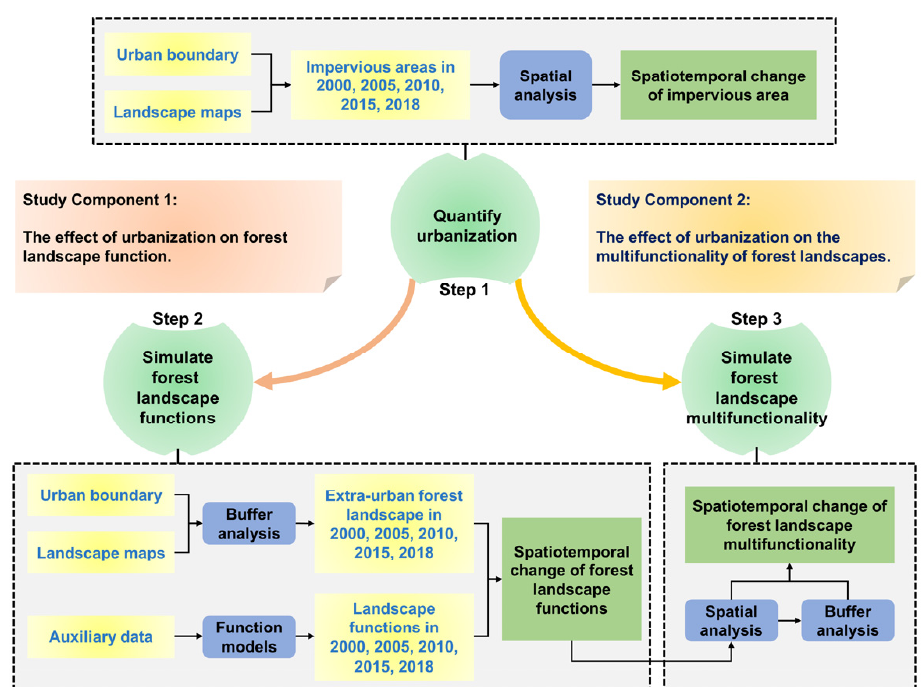
Figure 2. The flowchart shows the research framework and technical route of this study. The habitat maintenance (HM) function refers to the ability of local forest landscape systems to maintain biodiversity. The present study assessed changes in HM functions between 2000–2018 using the Habitat Quality module of the Integrated Valuation of Ecosys- tem Services and Trade-offs (InVEST) model [35]. In this module, the mandatory input data include three categories: landscape type maps, threat data for maintaining habitat, and landscape sensitivity to threats. Maps of landscape types are available in the CLCD data. Threat data and sensitive data are determined by referring to the user manual of InVEST and related studies [35,37–39]. By investigating the landscape composition of the study area, we determined that the threat factors included cropland, impervious areas, and bare land. Table A1 shows the threat data and sensitive data used in this study. Equation (3) shows the basic formula for assessing HM function by